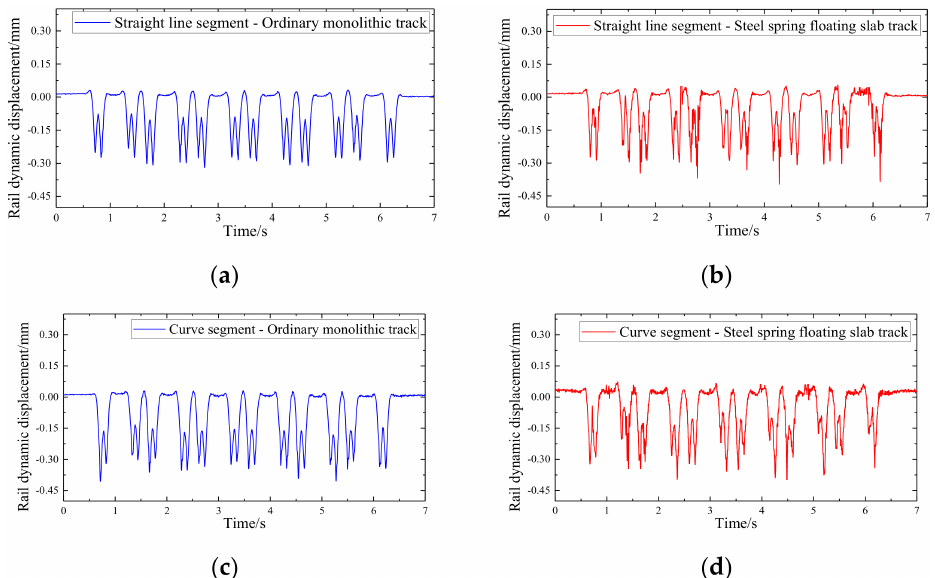
Figure 23. Time domain curve of rail dynamic displacement. ( a ) Straight line segment—ordinary monolithic track; ( b ) straight line segment—steel-spring-floating slab track; ( c ) curved segment— ordinary monolithic track; ( d ) curved segment—steel-spring-floating slab